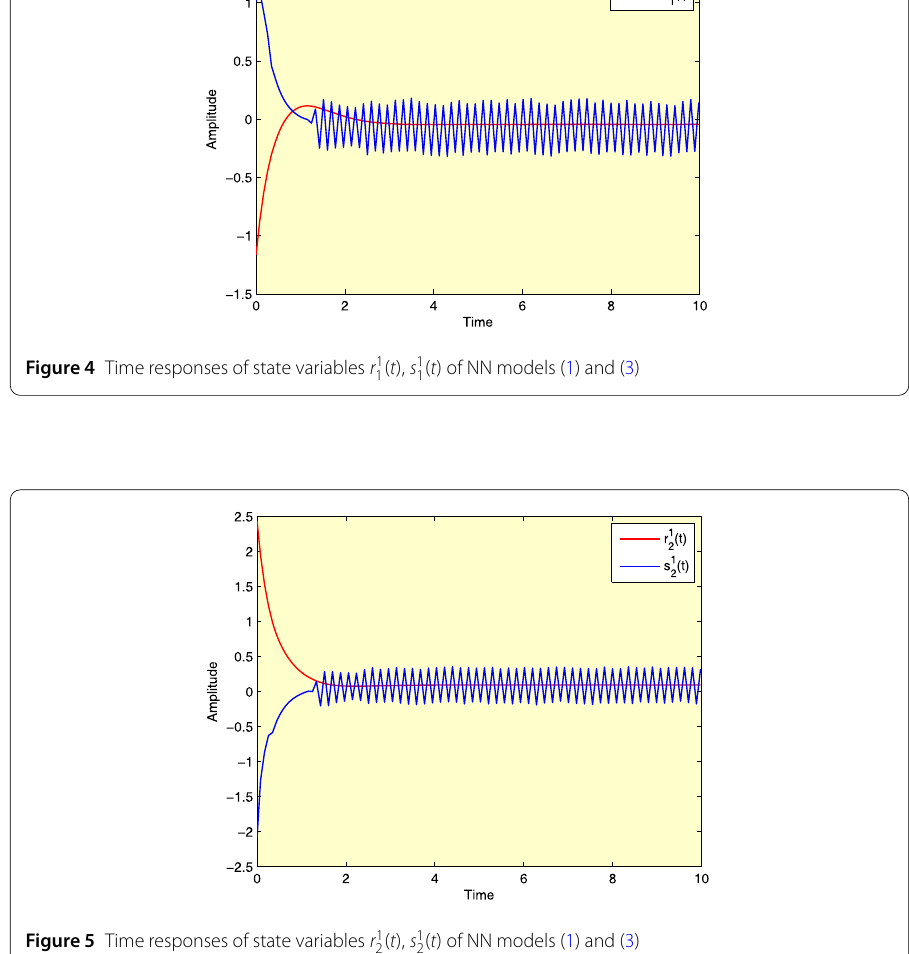
Figure 5 Time responses of state variables r 1 2 ( t ), s 1 2 ( t ) of NN models (1) and (3)